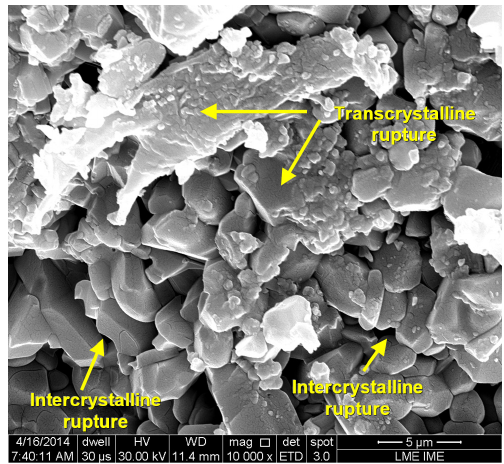
Figure 5. Fracture surface of a particle from the Al ballistic test.